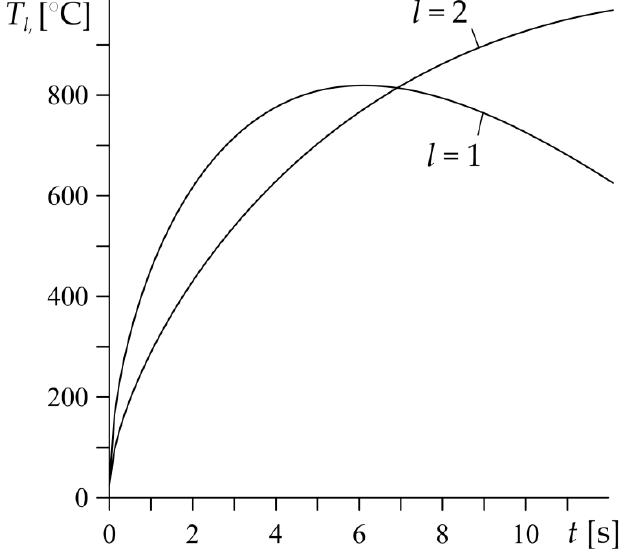
Figure 3. Isolines of the heat partition ratio α (69) in the coordinate system ( γ ∗ , K ε ).